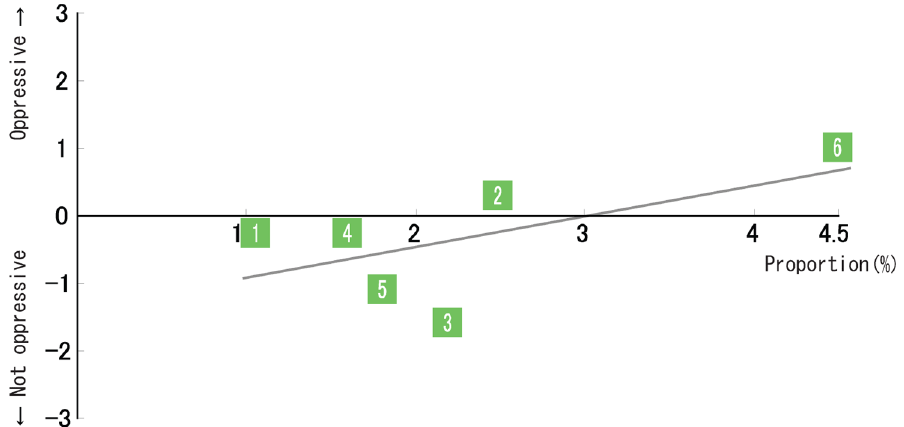
Figure 11. Correlation between proportion and oppressive feelings (projection advertising signs).